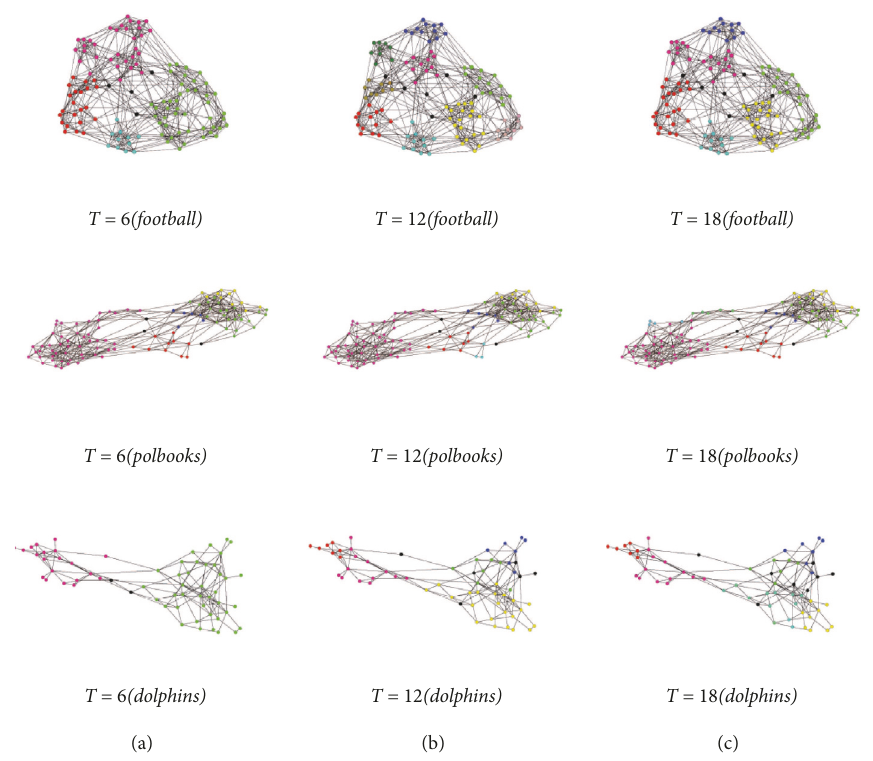
Figure 6: The communities for 𝑇 = {6, 12,18} (the black nodes are overlapping